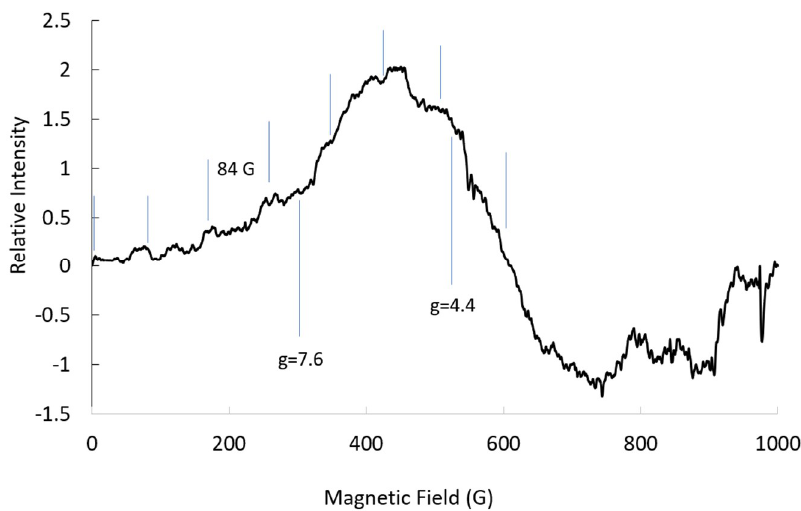
Figure 2. S-band (3.229 GHz) EPR spectrum for CoEDTA: temp., 18 K; microwave power, 16 dB; 9 scans averaged. Vertical lines indicate the Co hyperfine lines, eight (assuming the center is g = 7.6).